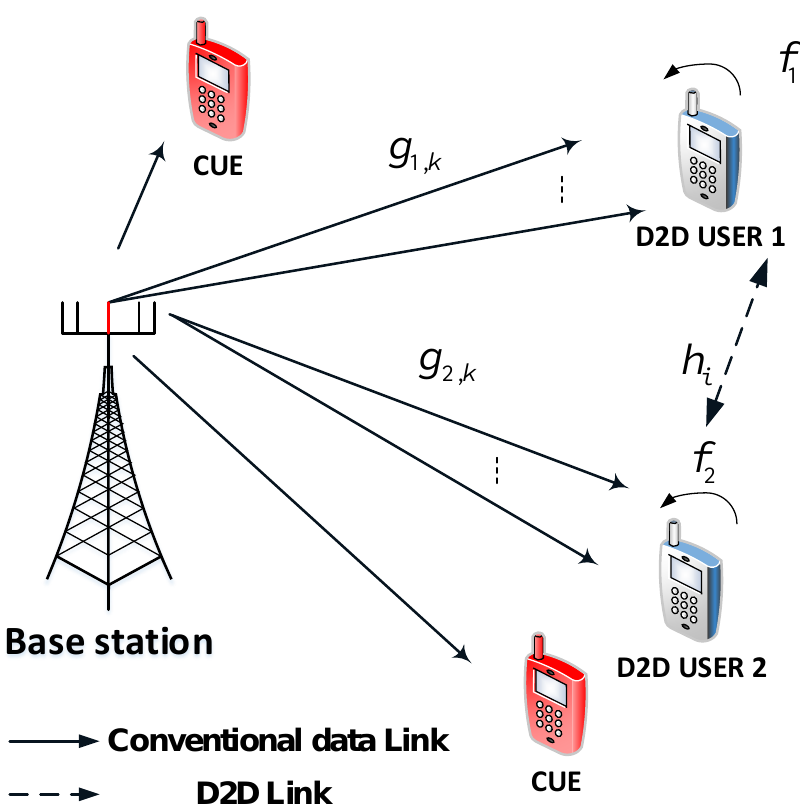
Figure 1. System model of FD aware D2D transmission mode in Power Domain based Multiple Access with Multiple Antenna at the